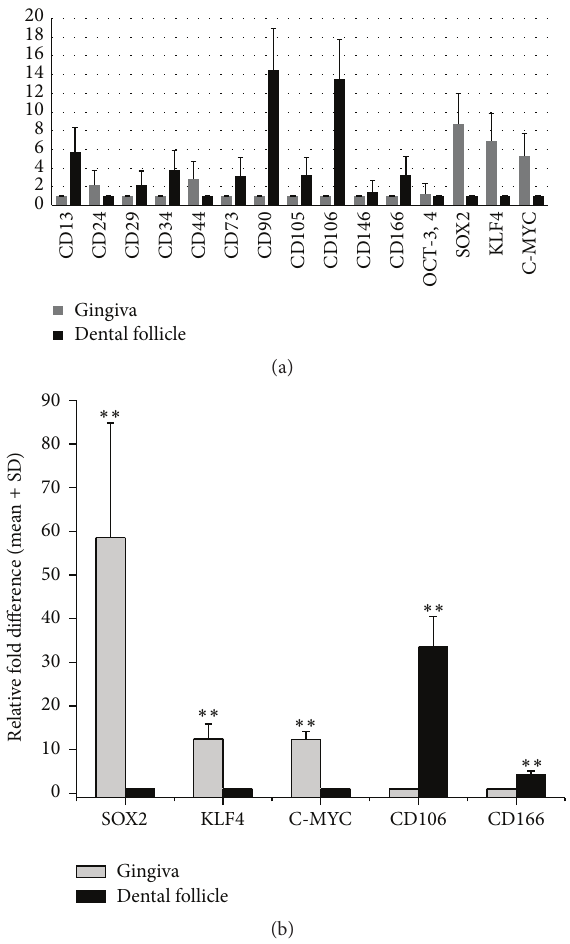
Figure 4: The relative gene expression of dental-derived stem cell and induced pluripotent stem cell markers using cDNA microarray (a). The relative fold difference in the expression of five stem cell marker genes between the gingiva and dental follicles using quantitative RT-PCR (b). The data are presented as the mean + standard deviation (a, b) and expressed as the relative change by applying the equation 2 −ΔΔ Ct (b). ∗∗ 𝑝 < 0.05